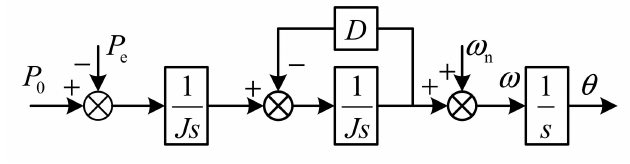
Figure 3. Structure of virtual moment of inertia